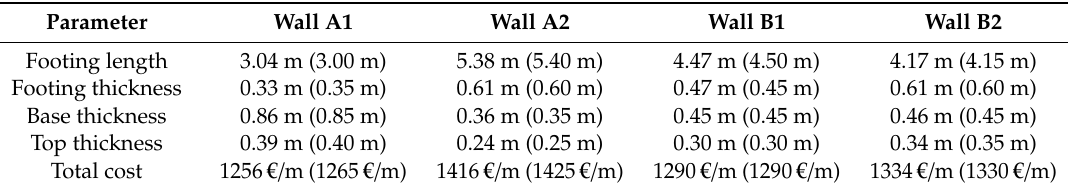
Table 3. Optimization